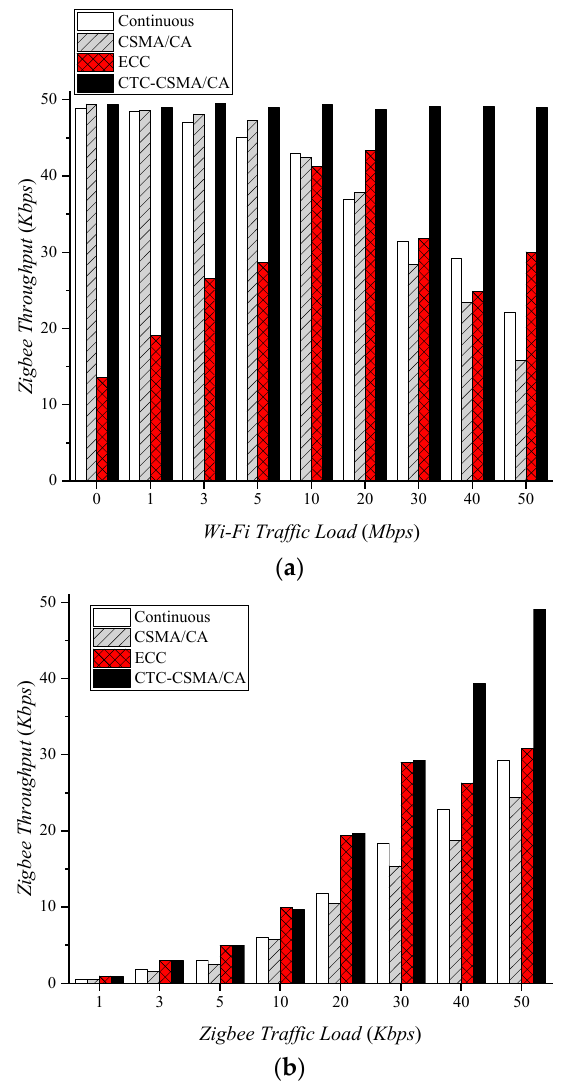
Figure 9. Zigbee throughput according to traffic load. ( a ) Wi − Fi traffic load, ( b ) Zigbee traffic load. We assume ECC and CTC-CSMA/CA transmit Zigbee packets only during white space. ECC shows the highest white space of 17.34 ms with a 20 Mbps traffic load (Figure 9a), since the white space is determined by the randomness of Wi-Fi traffic. Zigbee transmits packets without interference during this white space, resulting in a throughput of 43.45 Kbps. It is still not enough white space to deal with 50 Kbps traffic. In CTC-CSMA/CA, Zigbee provides nearly a 50 Kbps throughput because it almost satisfies the white space requirement. As in Figure 9a, CTC-CSMA/CA obtains 25.66%, 29.52%, and 70.62% throughput gains compared to continuous, CSMA/CA, and ECC, respectively. To investigate the effect of Zigbee traffic load on Zigbee throughput, Wi-Fi traffic was fixed at 40 Mbps. Figure 9b shows Zigbee throughput according to Zigbee traffic load. In the case of continuous and CSMA/CA, throughput increases as Zigbee traffic increases.